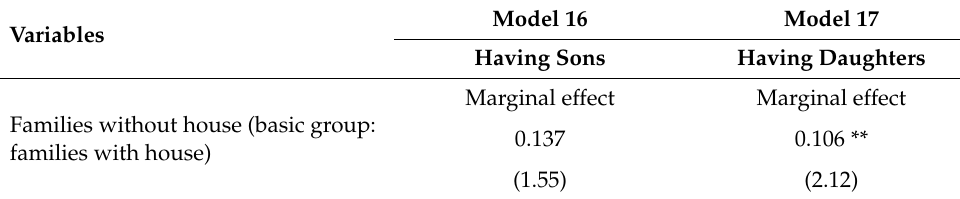
Table 6. Having sons, real estate purchases, and migrant women’s overtime